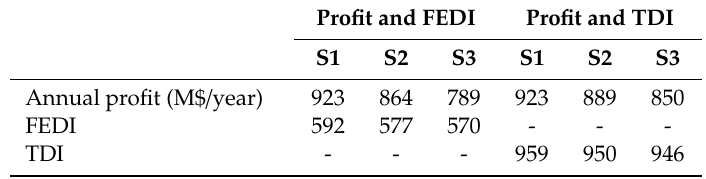
Figure 10. The optimal biorefinery configuration of the optimal point S3 for profit and fire explosion damage index in Figure 8a. Table 10. Optimal objective values corresponding to the selected Pareto-optimal points in Figure